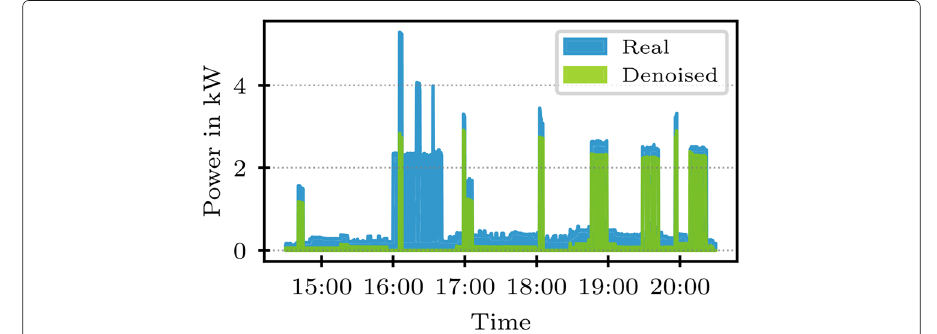
Fig. 2 Real and denoised aggregate in the case of REFIT house